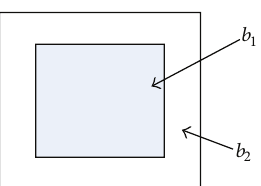
Figure 3: Schematic diagram of soft morphology structuring ele- ment 𝑏